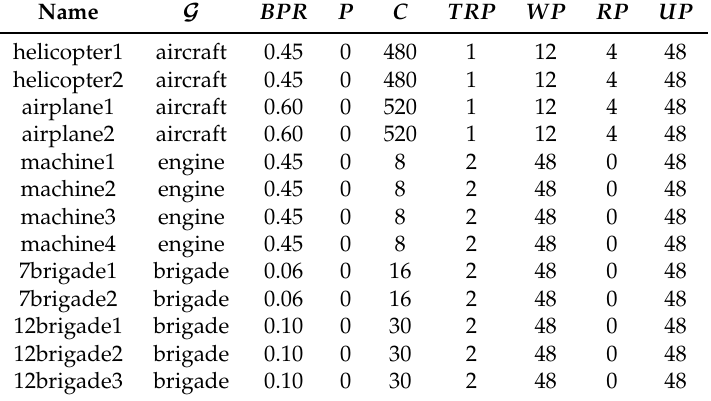
Table 1. Description of resources and some associated parameters (abbreviations are defined in Section 2.1).